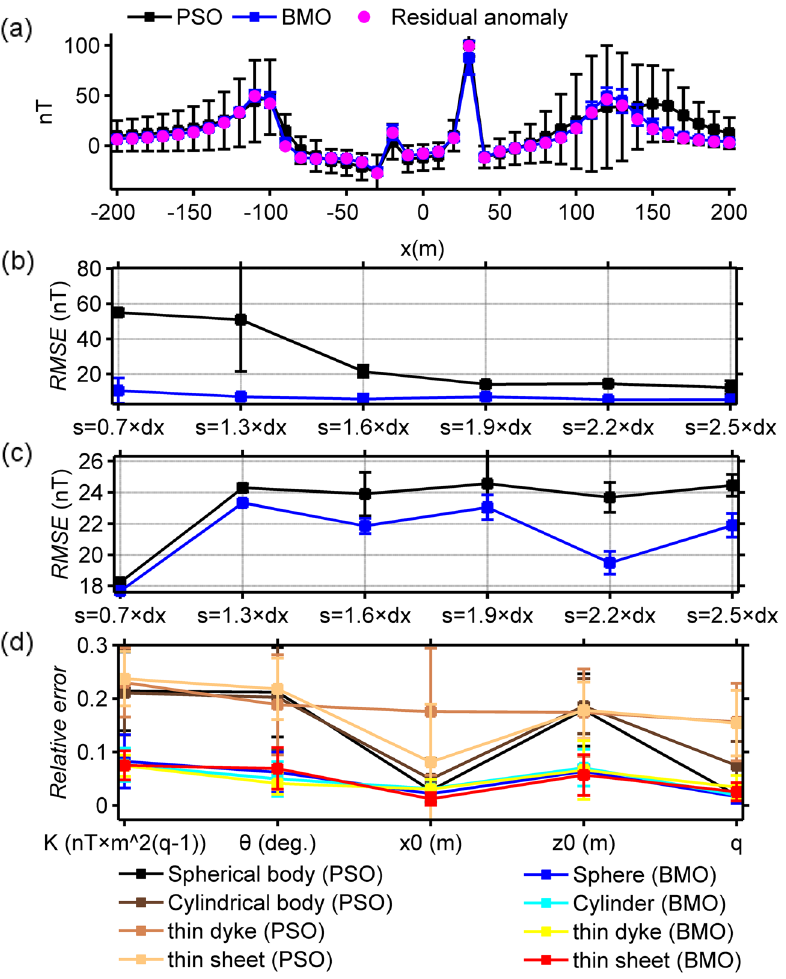
Figure 12. Inversion results of case 3 with the implementation of the SMA technique. ( a ) fittings between the residual magnetic anomaly and the responses obtained via BMO and sPSO, ( b ) variation behaviors of the calculated RMSE values between the uncontaminated magnetic anomaly of case 1 and the residual responses obtained via BMO and sPSO for different s values, ( c ) variation behaviors of the computed RMSE values between the calculated SMA magnetic anomalies of case 3 and the estimated SMA magnetic responses of BMO and sPSO for different s values, ( d ) relative errors of the calculated average estimation of the obtained model parameters using BMO and sPSO for four causative sources from the SMA magnetic anomalies for different s values. Error bars are also given in ( a )–( d